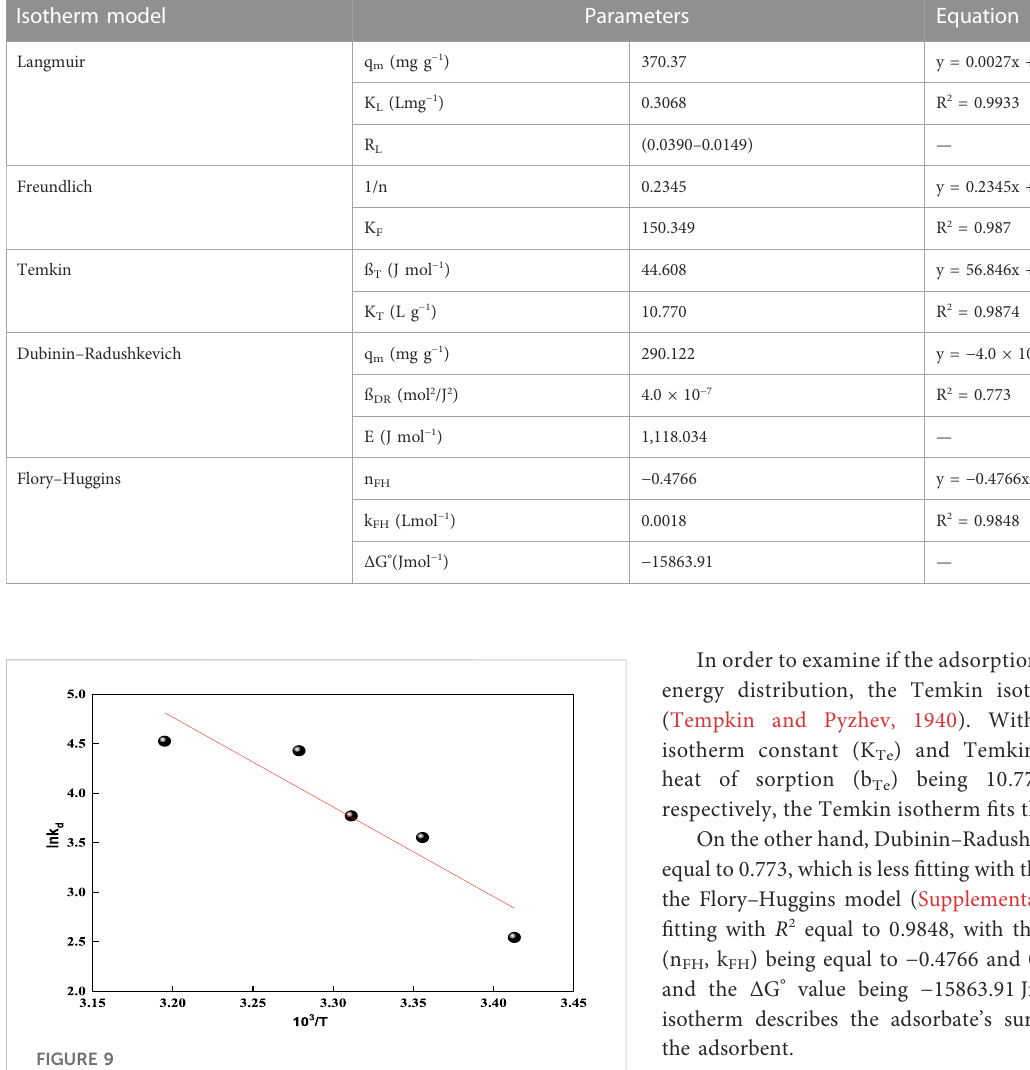
FIGURE 9 Representation of Van ’ t Hoff equation for acid red 37 dye adsorption onto CM- β